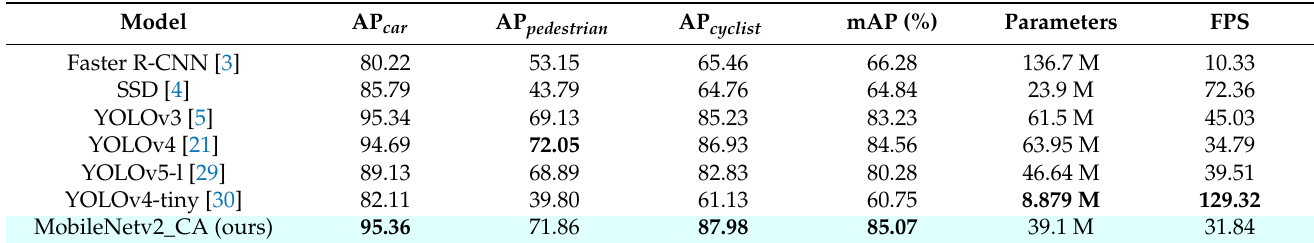
Table 4. Performance comparison of different detection networks on KITTI